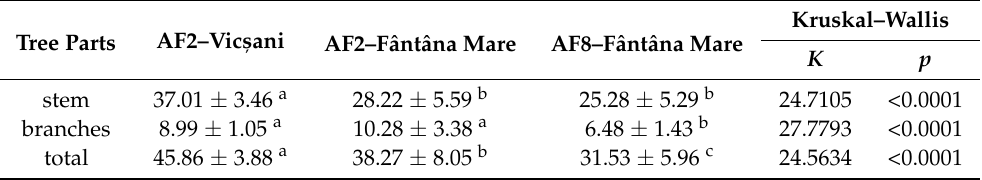
Table 3. The biomass per hectare accumulated on tree parts after five growing seasons (Mg · ha − 1 , mean ±